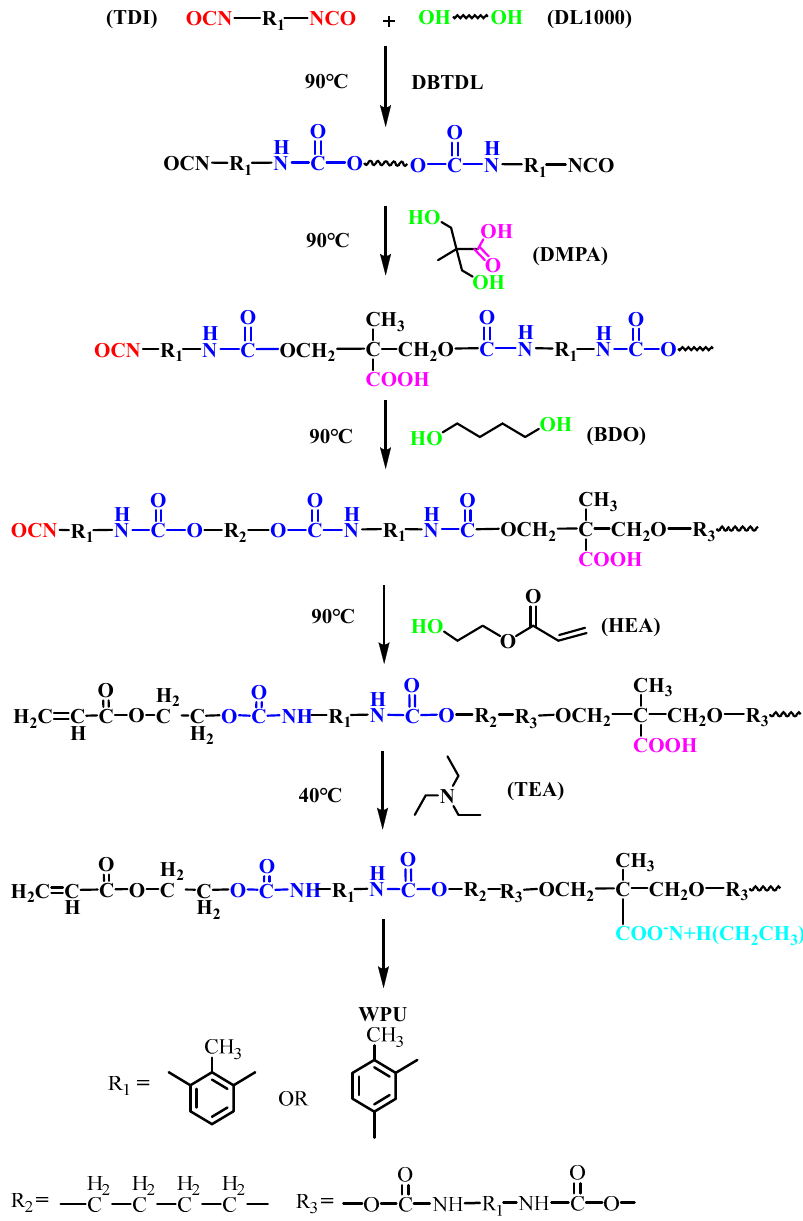
Figure 1. Synthetic route of WPU. The groups with colors in the figure represent the groups involved in the reaction. Red represents − NCO, green represents − OH, blue represents − NHCOO, purple represents − COOH, and cyan represents − COO − N + H(CH 2 CH 3 ) 3 .